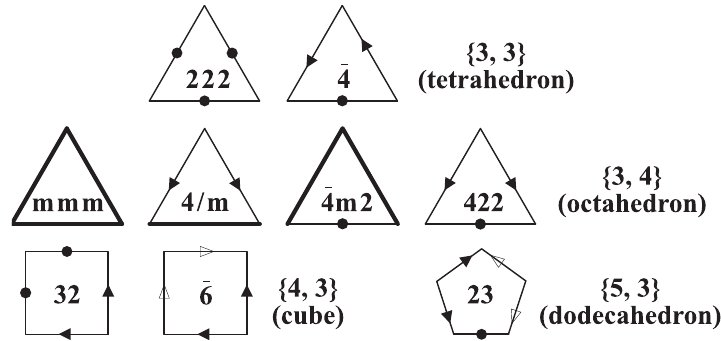
Figure 6. Edge identifications of the regular triangles, the square and the regular pentagon, generating fundamental spherical